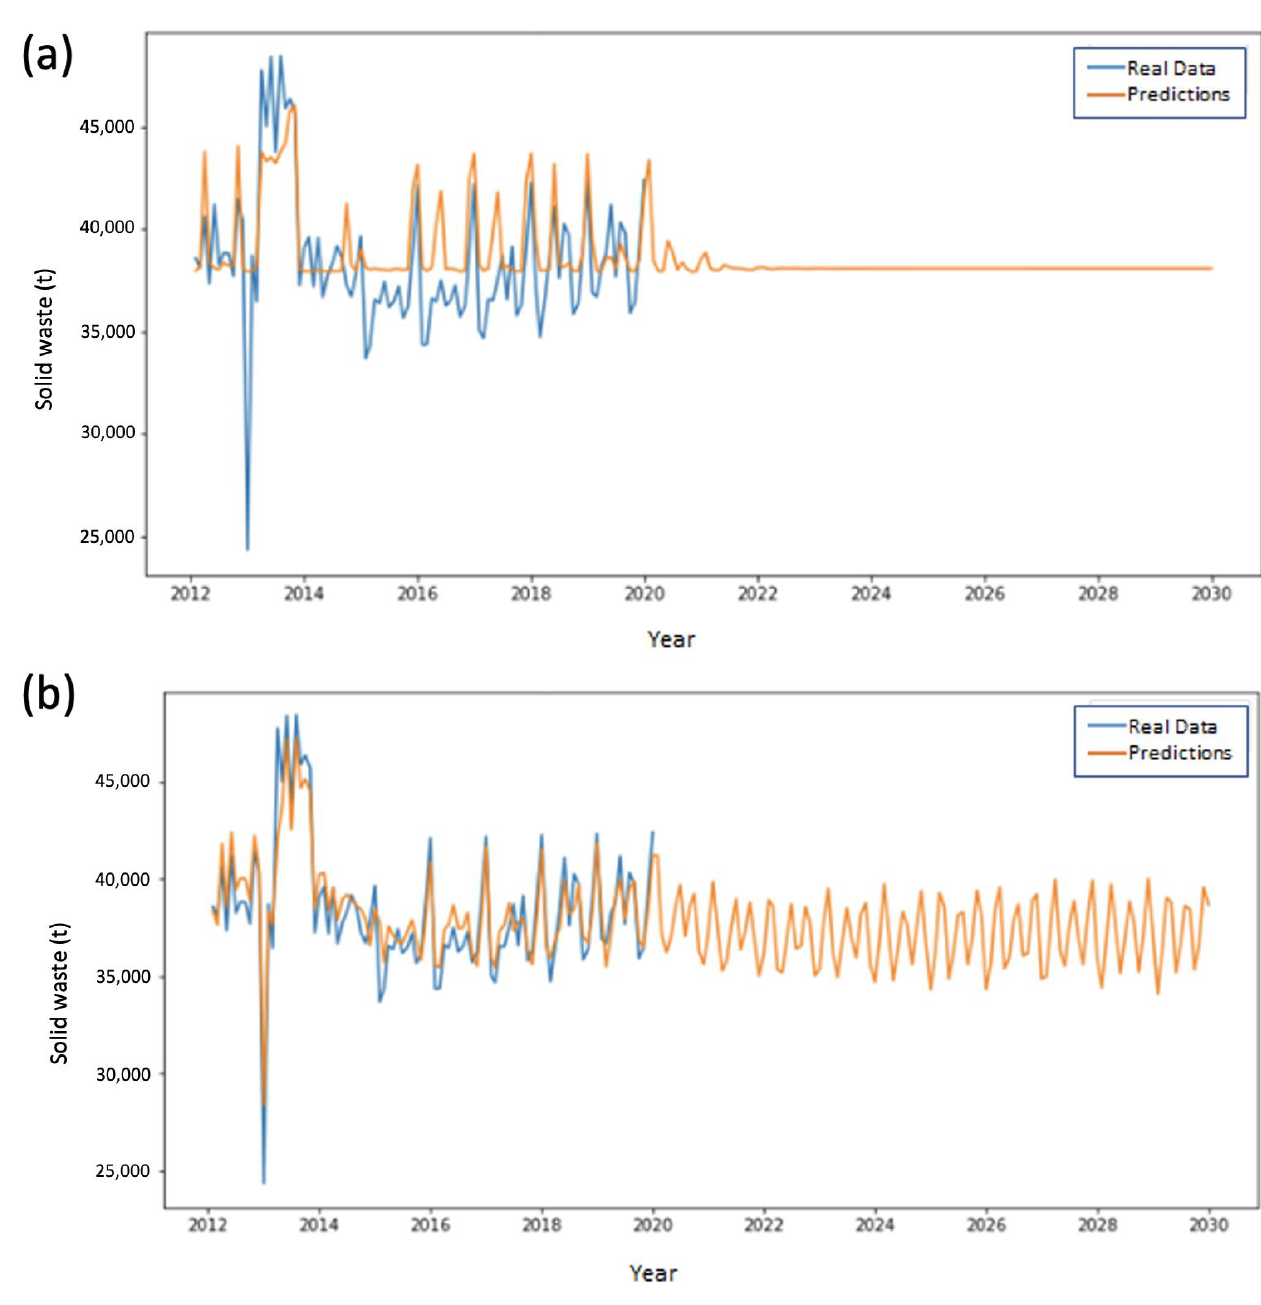
Figure 7. Performance comparison in the training and prediction for ESA Zone 3 using ( a ) LSTM and ( b ) SVMs.